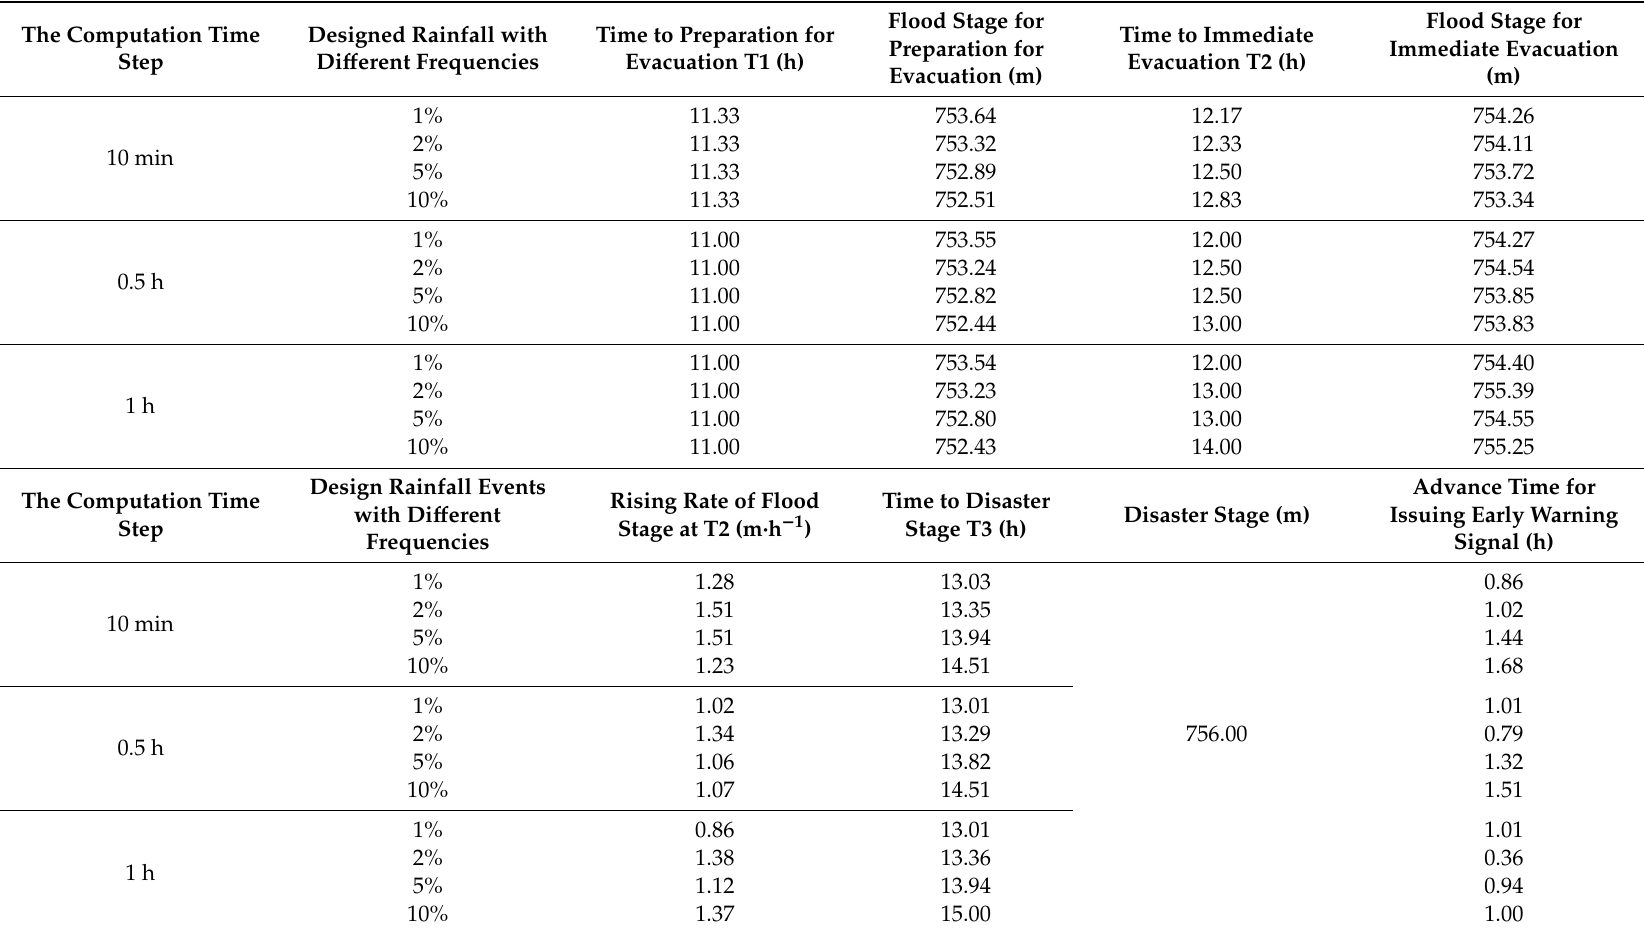
Table 9. Early warning index based on the rising rate of the flood